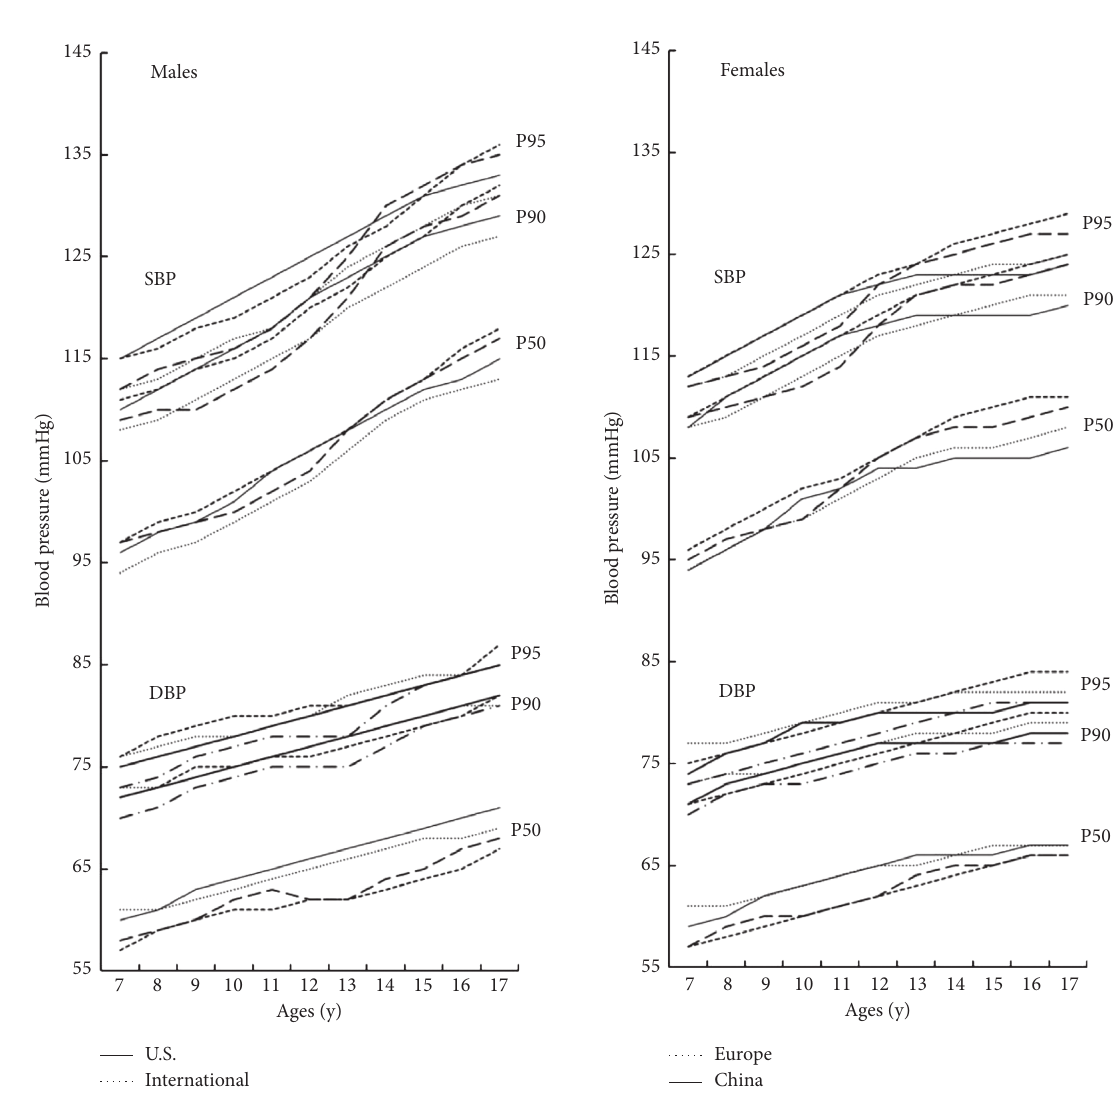
Figure 1: The 50 th , 90 th , and 95 th percentiles of 4 BP references for males and females aged 7 to 17 years at median